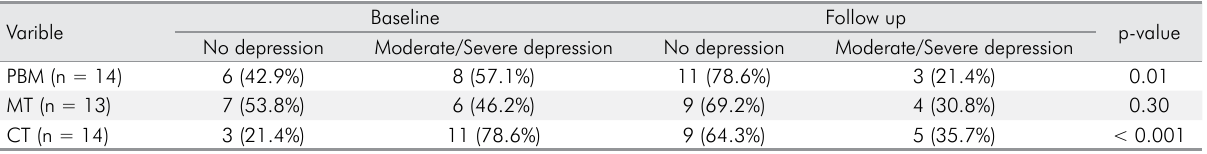
Table 5. RDC axis II: Assessment of D2 (degree of depression).